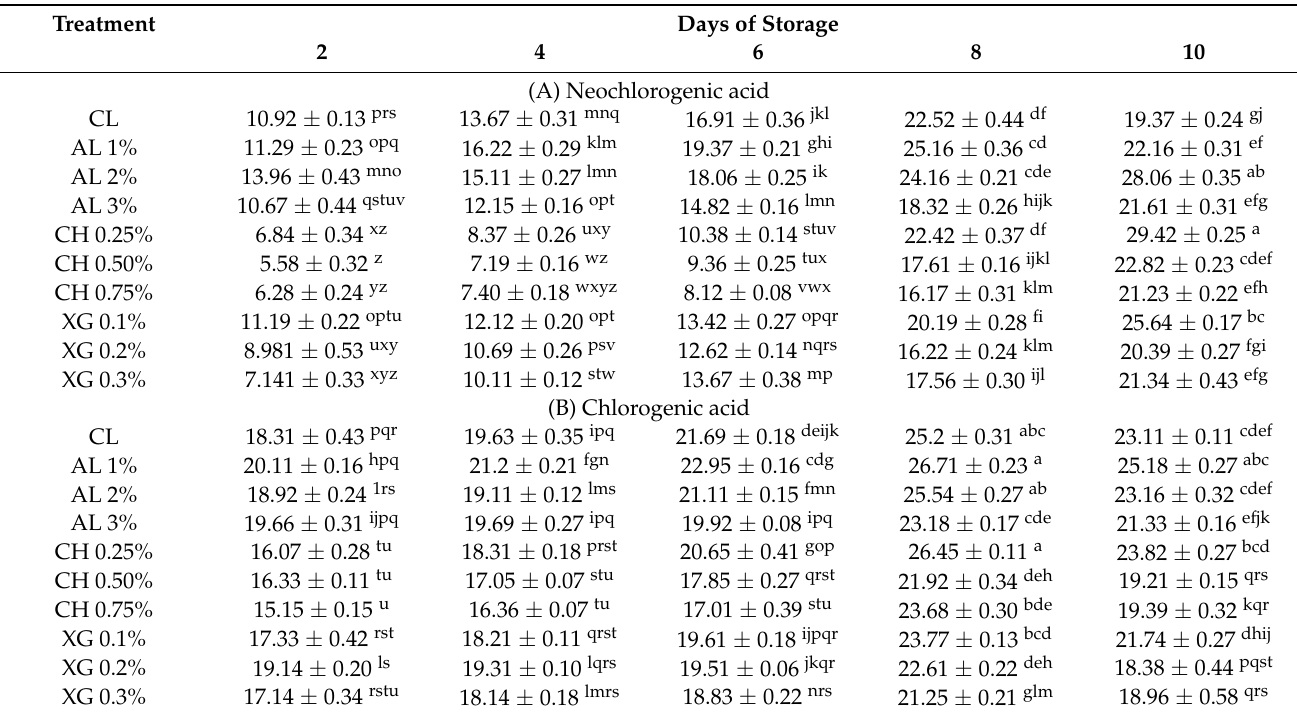
Table 3. Effects of polysaccharide-based coatings and storage on neochlorogenic acid, chlorogenic acid, ellagic acid and epicatechin levels (mg/Kg DW).